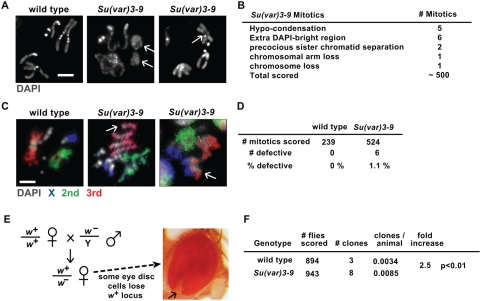

Su(var)3-9 somatic cells exhibit genome instability phenotypes.A) DAPI staining of mitotic chromosomes from wild type and Su(var)3-9 mutant diploid cells. Structural defects in Su(var)3-9 mitotic chromosomes are indicated by white arrows. Each image is an optical section; bar = 2 mm. B) The chart shows quantitation of defective Su(var)3-9 mitotic chromosomes. Some mitotic chromosomes exhibited more than one defect. C) Chromosome painting of mitotic chromosomes from wild type and Su(var)3-9 mutant. Red = 3rd chromosomes, green = 2nd chromosomes, and blue = X chromosomes. Fourth and Y chromosomes are only stained with DAPI. Structural defects, such as deletions and translocations, are indicated by white arrows. Each image is an optical section; bar = 2 mm. D) Quantitation showed that 1.1% of the Su(var)3-9 mitotic chromosomes exhibited structural defects, compared to 0% for wild type (p<0.05 by Chi-square test). E) The diagram illustrates the genetic assay used to quantitate genome instability (loss of heterozygosity) in wild type and Su(var)3-9 animals. Wild type virgin flies were mated with males hemizygous for w
− (recessive white
1118 mutation) to produce females heterozygous for w
− and w
+. A clone of w− adult eye cells (pictured) arises during larval development when the w
+ allele is lost due to mitotic recombination, deletion, or chromosome loss events. f) Quantitative analysis of w− clone frequencies in wild type and Su(var)3-9 animals. The p values were calculated using the Chi-square test.